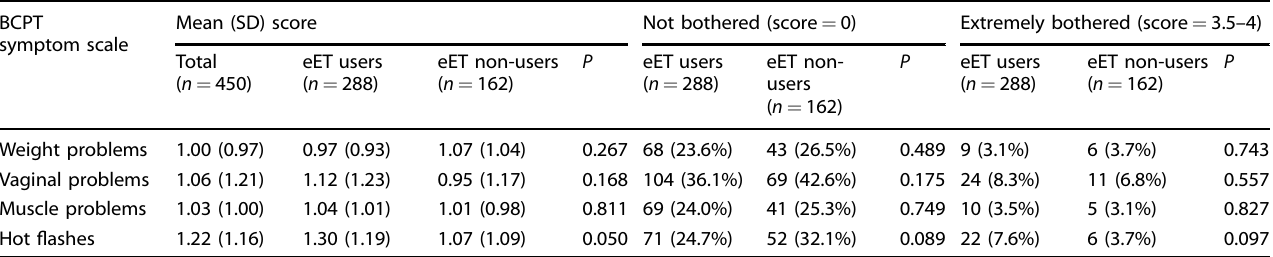
Table 3. Sub analysis of select endocrine-related symptoms reported in the fi rst 5 years post-diagnosis among extended endocrine therapy users and non-users a